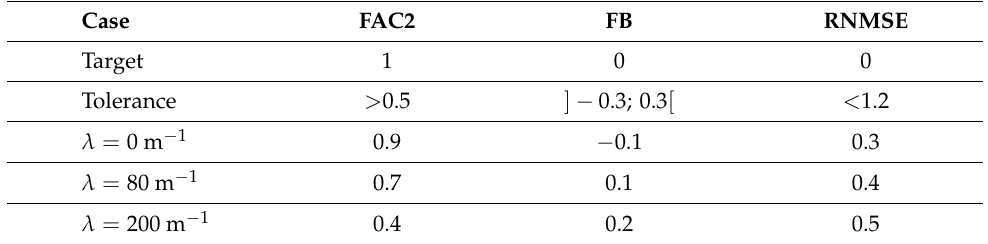
Table 4. Quality metrics for the street canyon. References according to Chang and Hanna